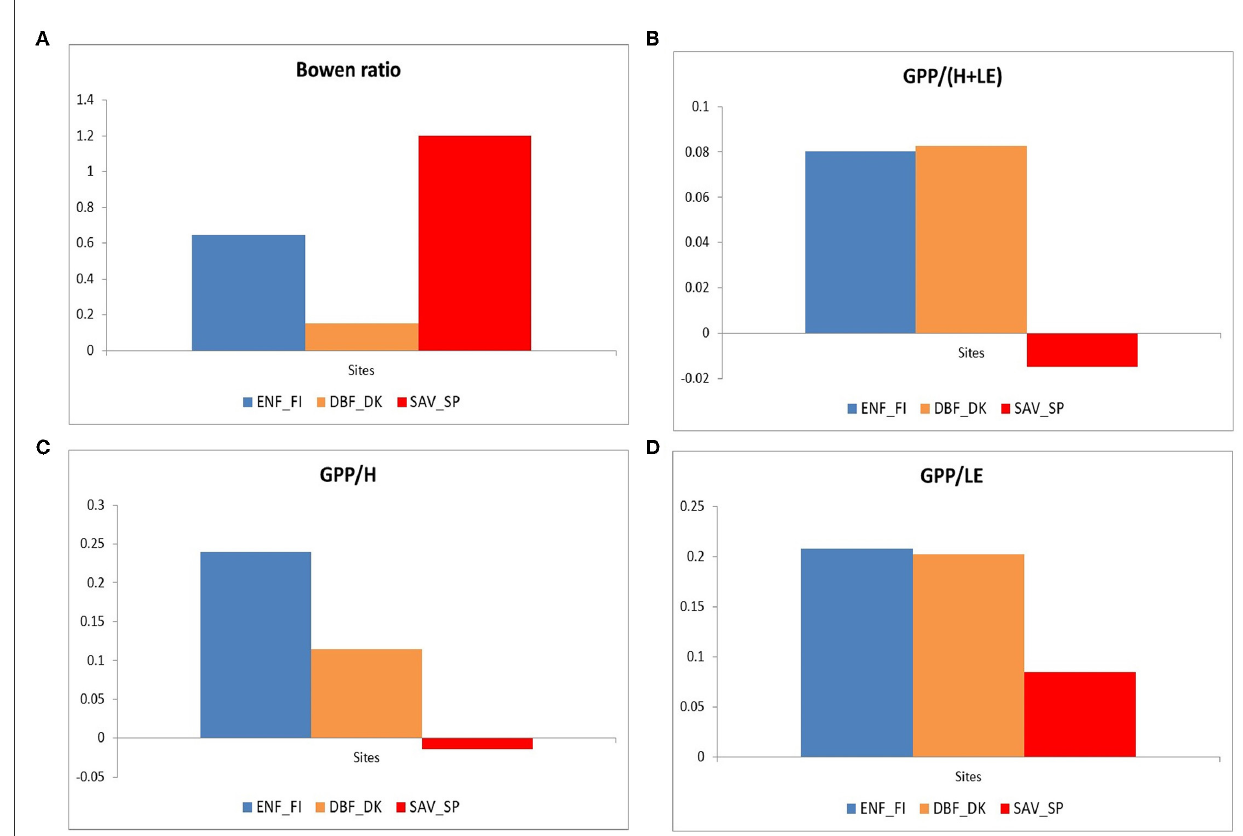
FIGURE6 Bowen ratio (A) , the ratio between GPP vs. the sum of sensible heat and latent heat (B) , the ratio between GPP and sensible heat (C) , and the ratio between GPP and latent heat (D) for the three European ecosystems (Evergreen Needleleaf Forest of Finland (ENF_FI, blue), Deciduous Broadleaf Forest of Denmark (DBF_DK, orange), and Mediterranean Savanna ecosystem of Spain (SAV_SP, red) during the growing period (April to October for the northern ecosystems and all year for the savanna